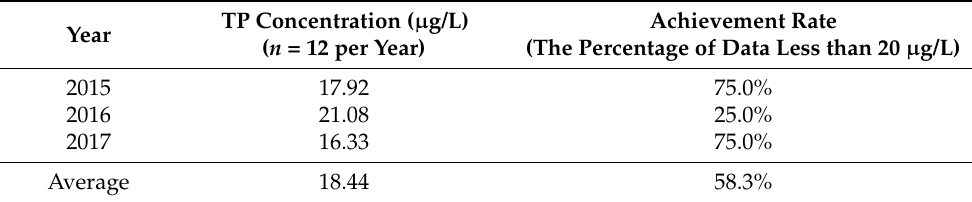
Table 1. The average TP concentration and the achievement rate of the Jinggualiao stream from 2015 to 2017.